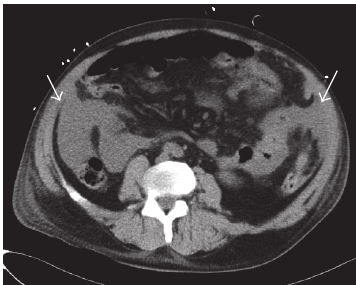
Figure 1: Nonenhanced CT scan of the abdomen shows blood in the peritoneal space (white arrows).